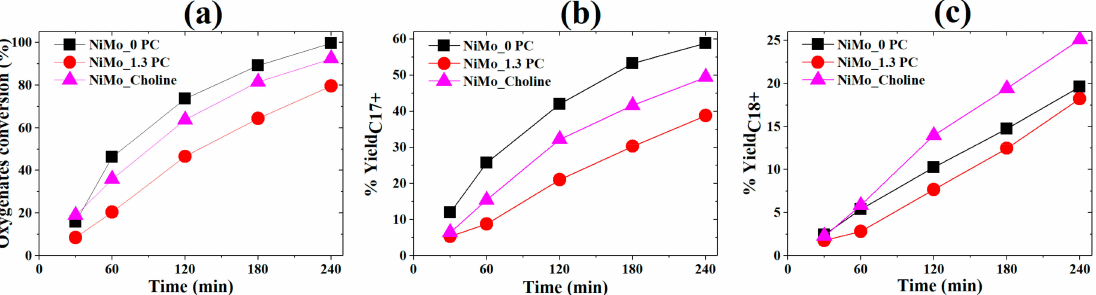
Figure 5. Effect of choline on the deoxygenation of oleic acid 54 bar and 320 ◦ C using 0.3 mL DMDS; ( a ) oxygenates conversion, ( b ) yield of C17+, ( c ) yield of